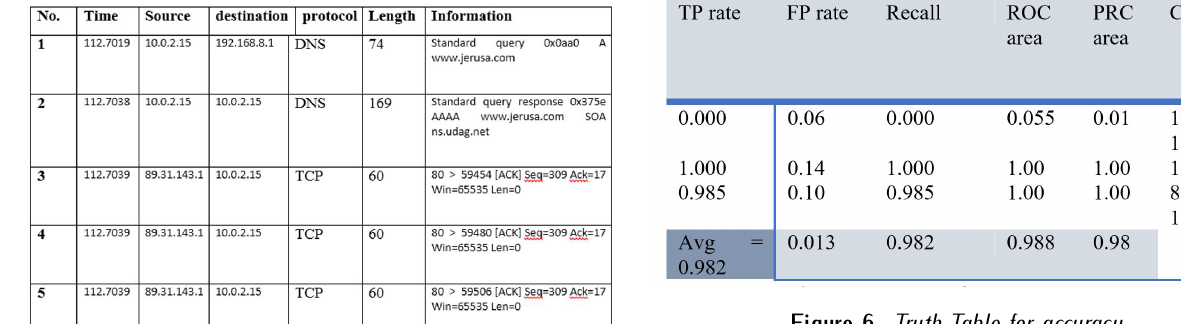
Figure 5. Snap Shot of Dataset